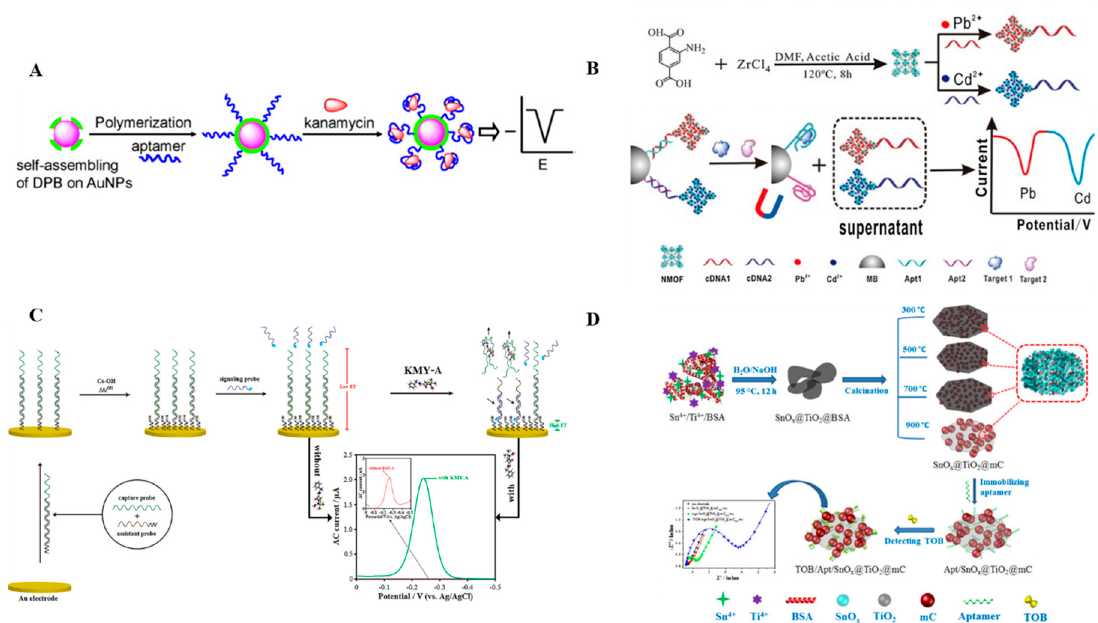
Figure 5. Schematic illustration of an electrochemical aptasensor. ( A ) Conductive polymer/gold self-assembled nanocomposite [76]. ( B ) Aptamer–metal ion nanoscale metal organic framework